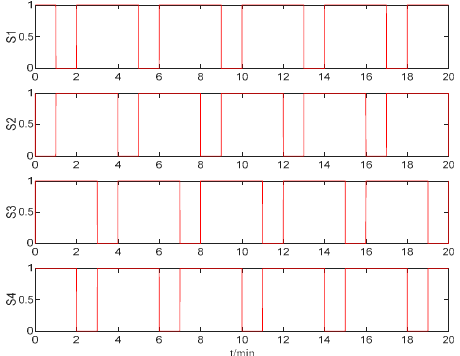
Figure 7. Dynamic redundant ba tt ery management algorithm working process diagram. The simulation circuit is run, and the relay operation process of each ba tt ery in series is shown in Figure 8. A large resistance is connected in parallel at both ends of the relay to detect the opening and closing of the relay. The high level represents the closing of the relay, while the low level represents the disconnection of the relay. As can be seen from the fi gure, in each discharge cycle, three ba tt eries are at a high level and one ba tt ery is at a low level to meet the load requirements. The power supply process for the whole ba tt ery pack is a process of dynamic selection.